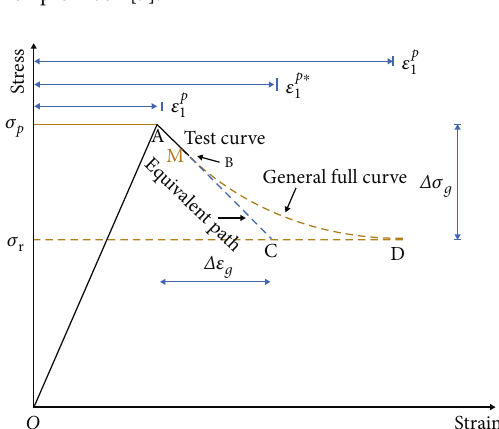
Figure 2: Strain-softening relationship of rock [7].